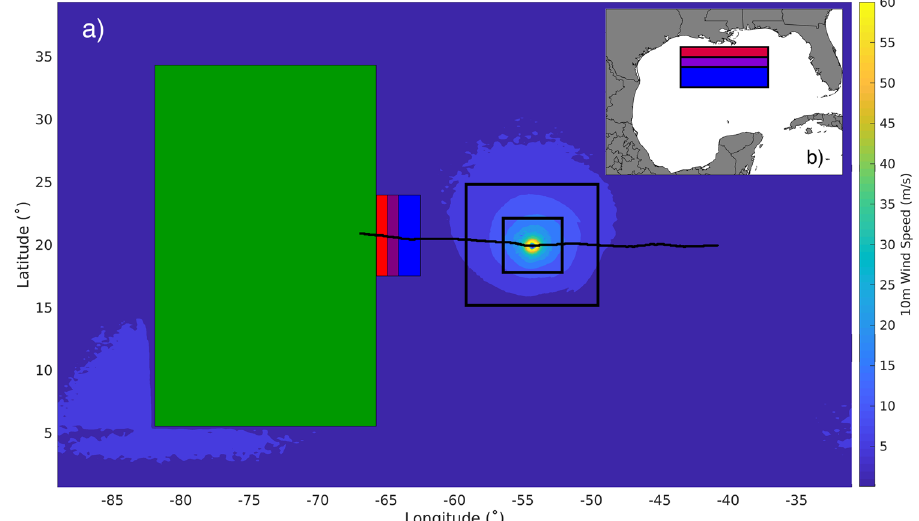
Fig. 3 Simulation domain set-up featuring example schematic of equivalent cool patch sizes for perspective. a Size of the TC wind fi eld at the time of initialization of the sensitivity experiments in relation to each domain, the land mass, the total eight-day track, and each of the three arti fi cially cooled patches. For reference, b reveals the size of each patch relative to the Gulf of